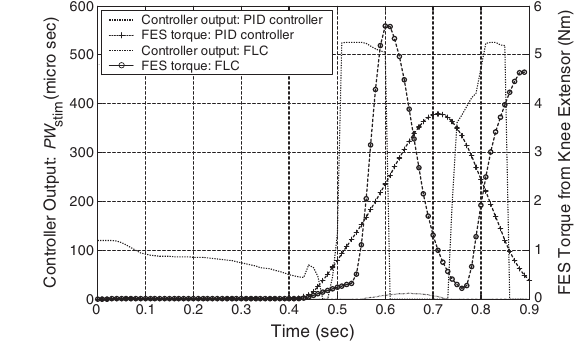
Fig. 14. Controller output and resultant FES induced active torque from PID and FL controller (control scheme-I).